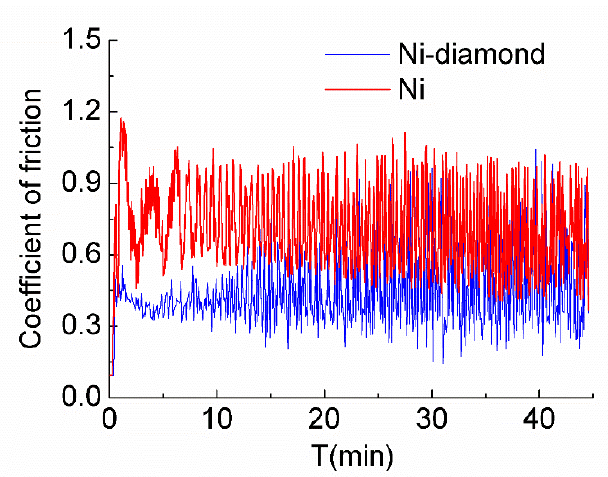
Figure 9. The friction coefficient of the Ni coating and the Ni–diamond coating during wear test.